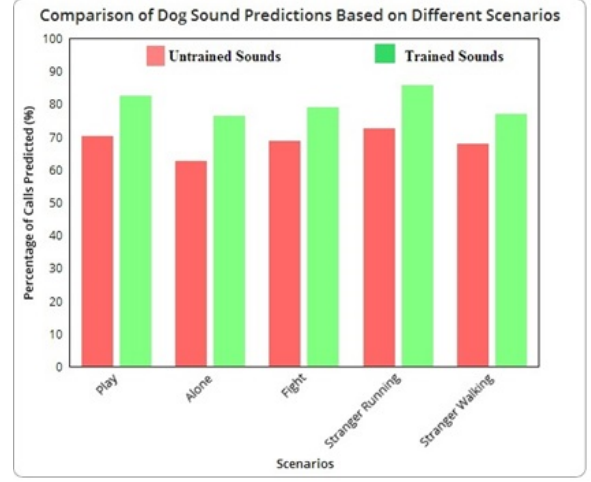
Figure 8. Comparison of prediction results between trained and untrained dog